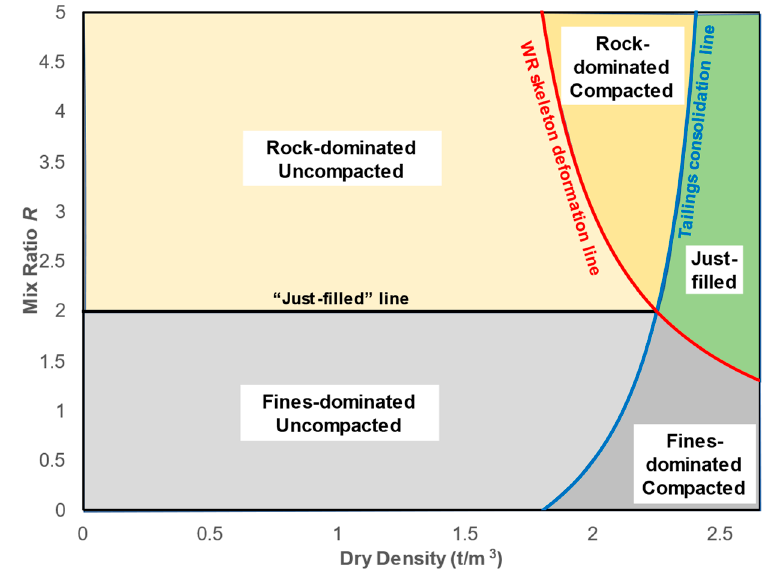
Figure 10. Material property boundary chart for a typical filtered tailings – waste rock blend.